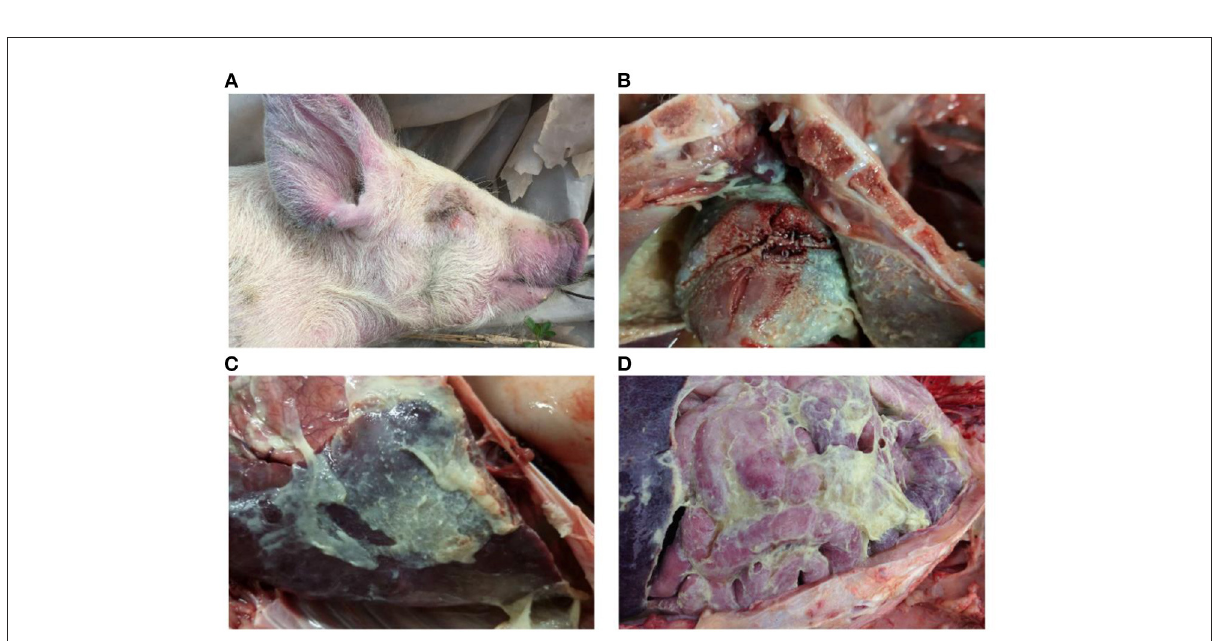
FIGURE2 Gross lesions of Glässer’s disease: (A) purple marks on the ears, skin around the eyes and tip of the nose of a pig that died of H. parasuis infection; (B) fibrinopurulent exudate on pericardial surface; and (C,D) fibrinopurulent exudate on serosal membranes in peritoneal and thoracic cavities. Photographs taken by the